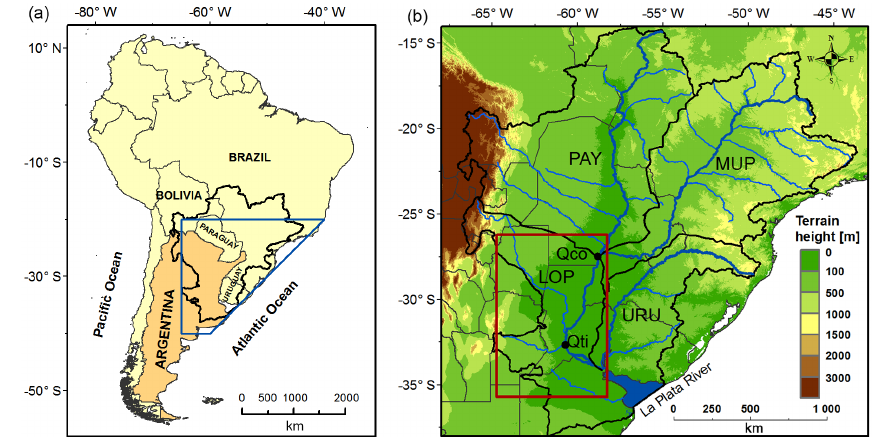
Figure 1. (a) South America and the domains of the La Plata Basin (bold black contour) and southeastern South America (blue polygon). (b) Topography map of La Plata Basin and its subbasins (black contours), Paraguay (PAY), Mid–Upper Paraná (MUP), Lower Paraná (LOP) and Uruguay (URU). The rivers and their tributaries are plotted in blue contours. Gauging stations of the Paraná River streamflow in Corrientes (Qco) and Timbúes (Qti) are highlighted. The study area in northeastern Argentina is highlighted with a red